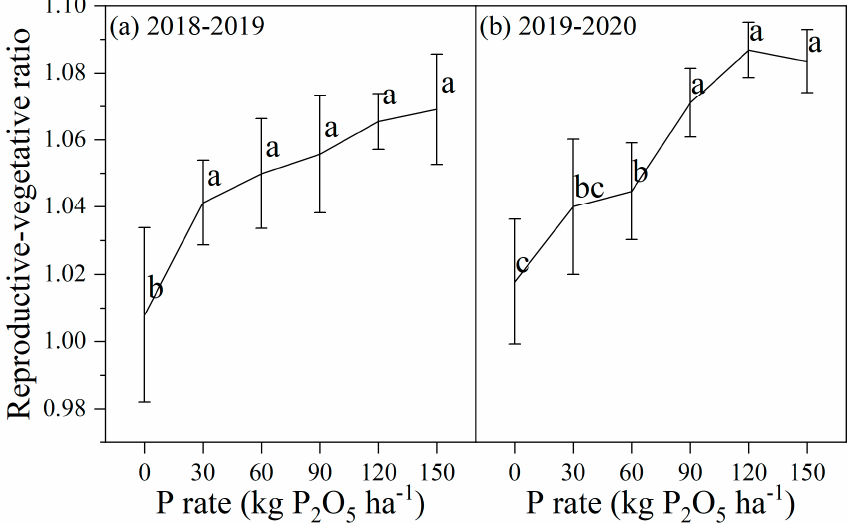
Figure 3. Effects of P rate on reproductive-vegetative ratio at maturity stage in saline environment. ( a ): 2018–2019 growing season; ( b ): 2019–2020 growing season. Different letters indicate significant difference at p = 0.05 between P rate treatments.